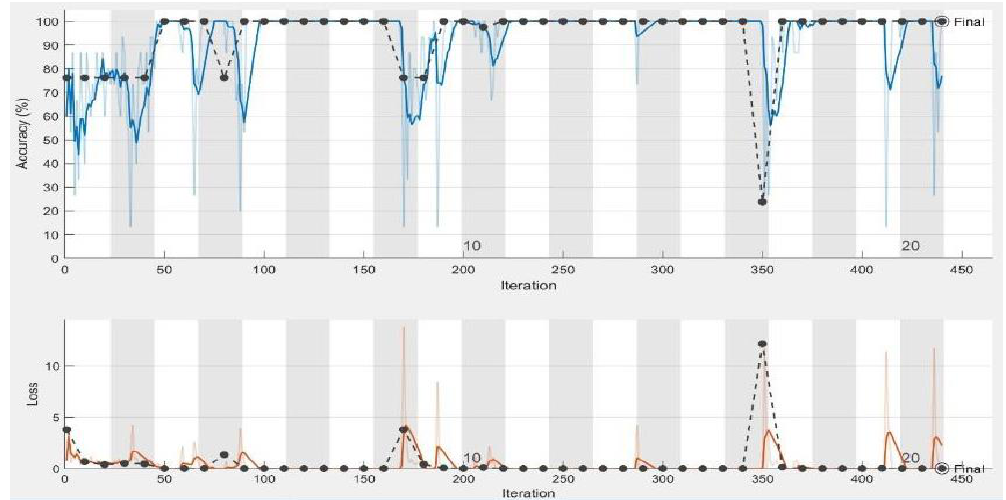
Figure 6. GoogLeNet training process with learning rate of 0.001. The figure shows the epoch number, training accuracy (blue line), validation accuracy (black line), and loss function value for the training data (red line) and validation data (black line).